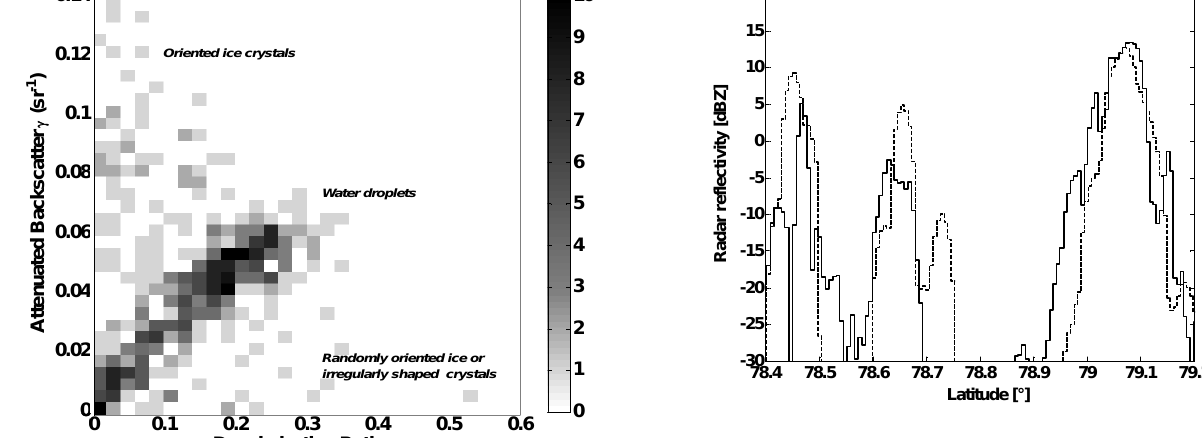
Fig. 7. Time-series of the reflectivity factor derived from CPI mea- surements (dotted line) and CloudSat reflectivity (full line) along the Polar-2 flight trajectory.